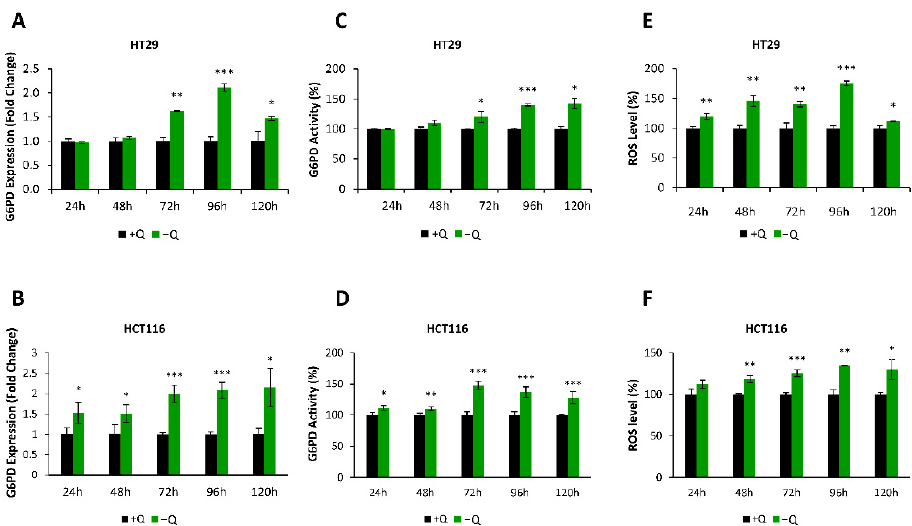
Figure 4. G6PD is modulated by glutamine availability. ( A , B ) G6PD mRNA expression at different time points after glutamine deprivation in ( A ) HT29 and ( B ) HCT116 cells ( − Q). Fold change was calculated with respect to cells cultured in a medium containing glutamine (+Q). ( C , D ) Total G6PD enzyme activity normalized to intracellular protein content measured at different time points after glutamine deprivation in ( C ) HT29 and ( D ) HCT116 cells. Fold change was calculated relative to cells cultured in a medium containing glutamine. ( E , F ) Relative ROS levels measured at different time points by flow cytometry using H 2 DCFA probes. ROS levels of ( E ) HT29 and ( F ) HCT116 cells cultured without glutamine ( − Q) are compared as fold change with respect to cells cultured with glutamine (+Q). One asterisk (*) denotes p -value < 0.05, two asterisks (**) denote p -value < 0.01 and three asterisks (***) denote p -value < 0.001.